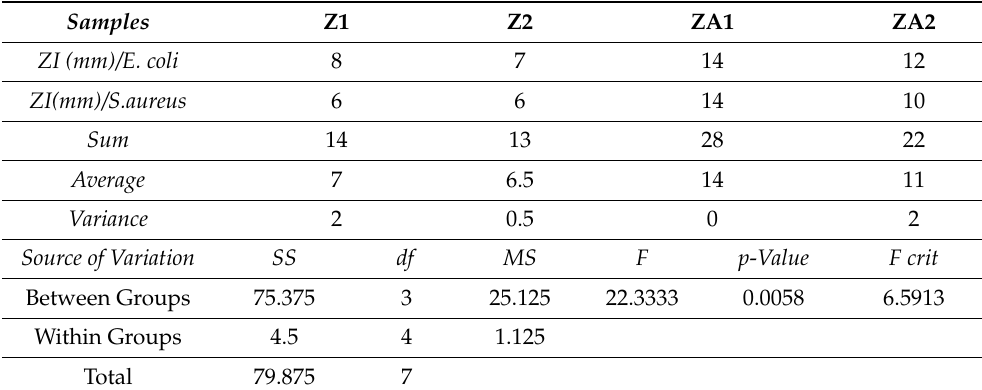
Table 2. The diameters of the inhibition zones for E. coli and S. aureus